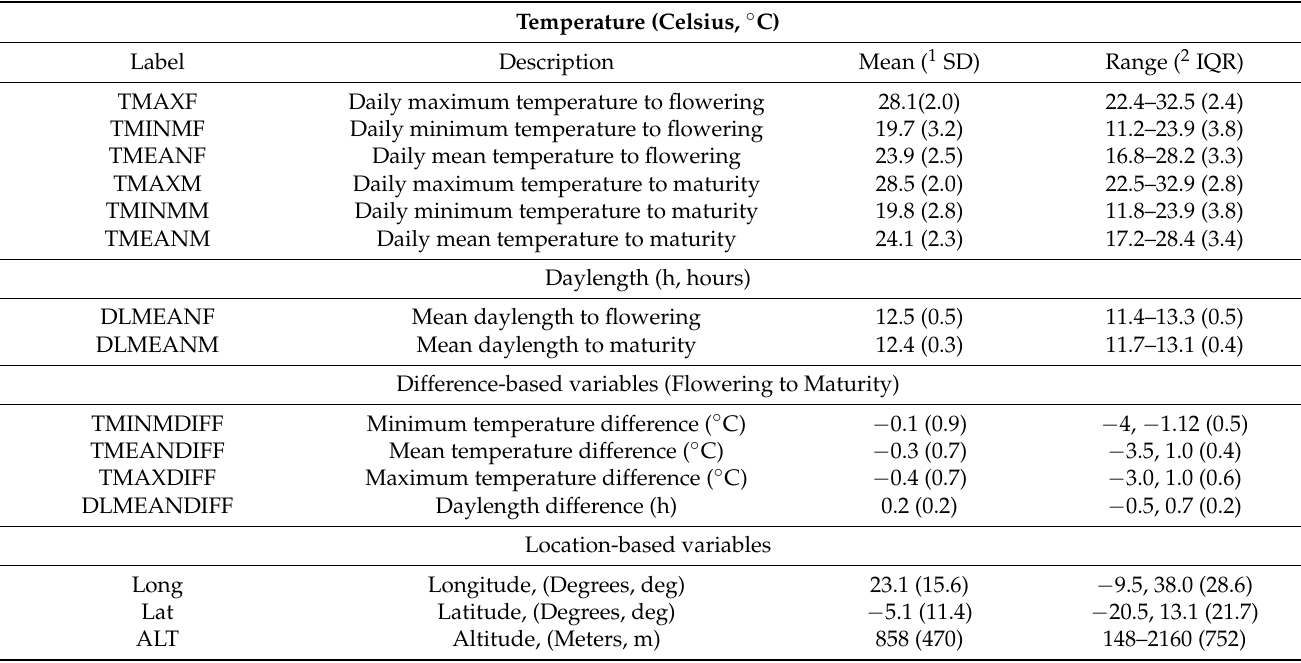
Table 1. Crop cycle seasonal features considered for soybean time to maturity (TTM) predictions. Temperature (Celsius, ◦